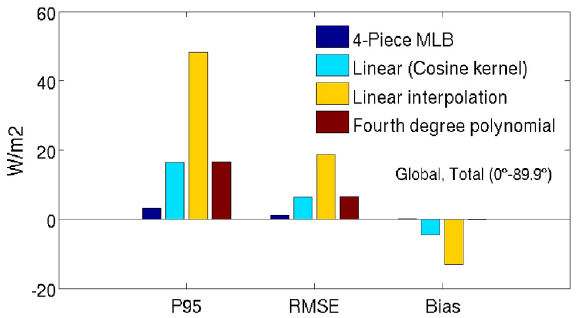
Figure 5. Comparison of errors for global total SSI (global perfor- mance of the four